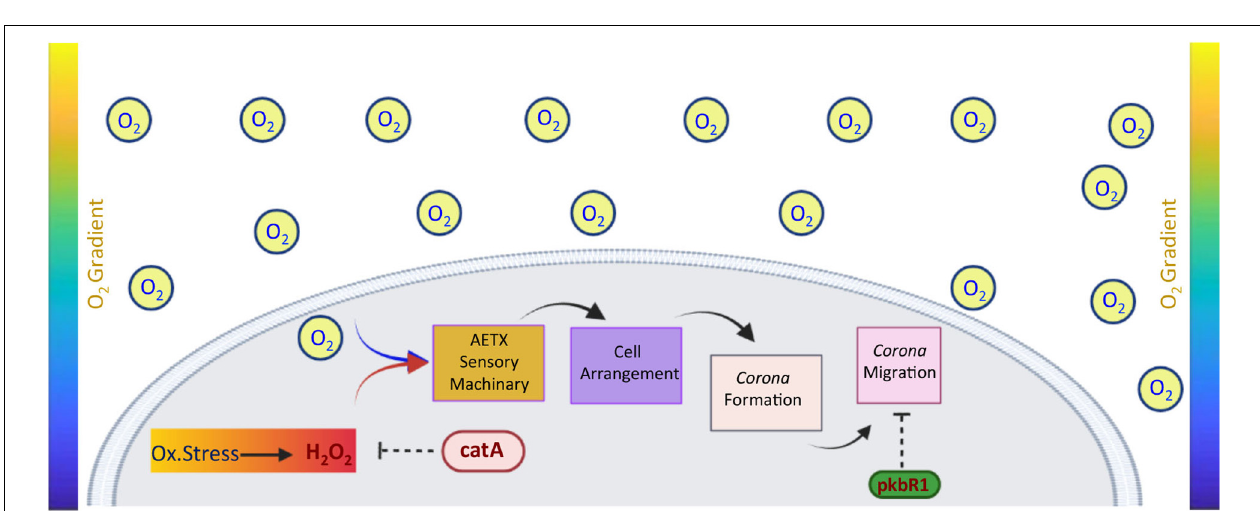
FIGURE 8 | Model of sensing and oriented migration of Dictyostelium cells under oxygen gradient. Under oxidative stress conditions, cells accumulate hydrogen peroxide up to a critical threshold (dark red in the rectangle). Once the latter is reached, the cells react and coordinately arrange themselves to give rise to a corona. These early events are regulated by unknown aerotaxis (AETX) sensory machinery/ies by which catalase A might represent either a regulatory component or a direct player. Afterward, the corona moves toward the higher concentration of oxygen, and its speed is negatively controlled by the PKBR1